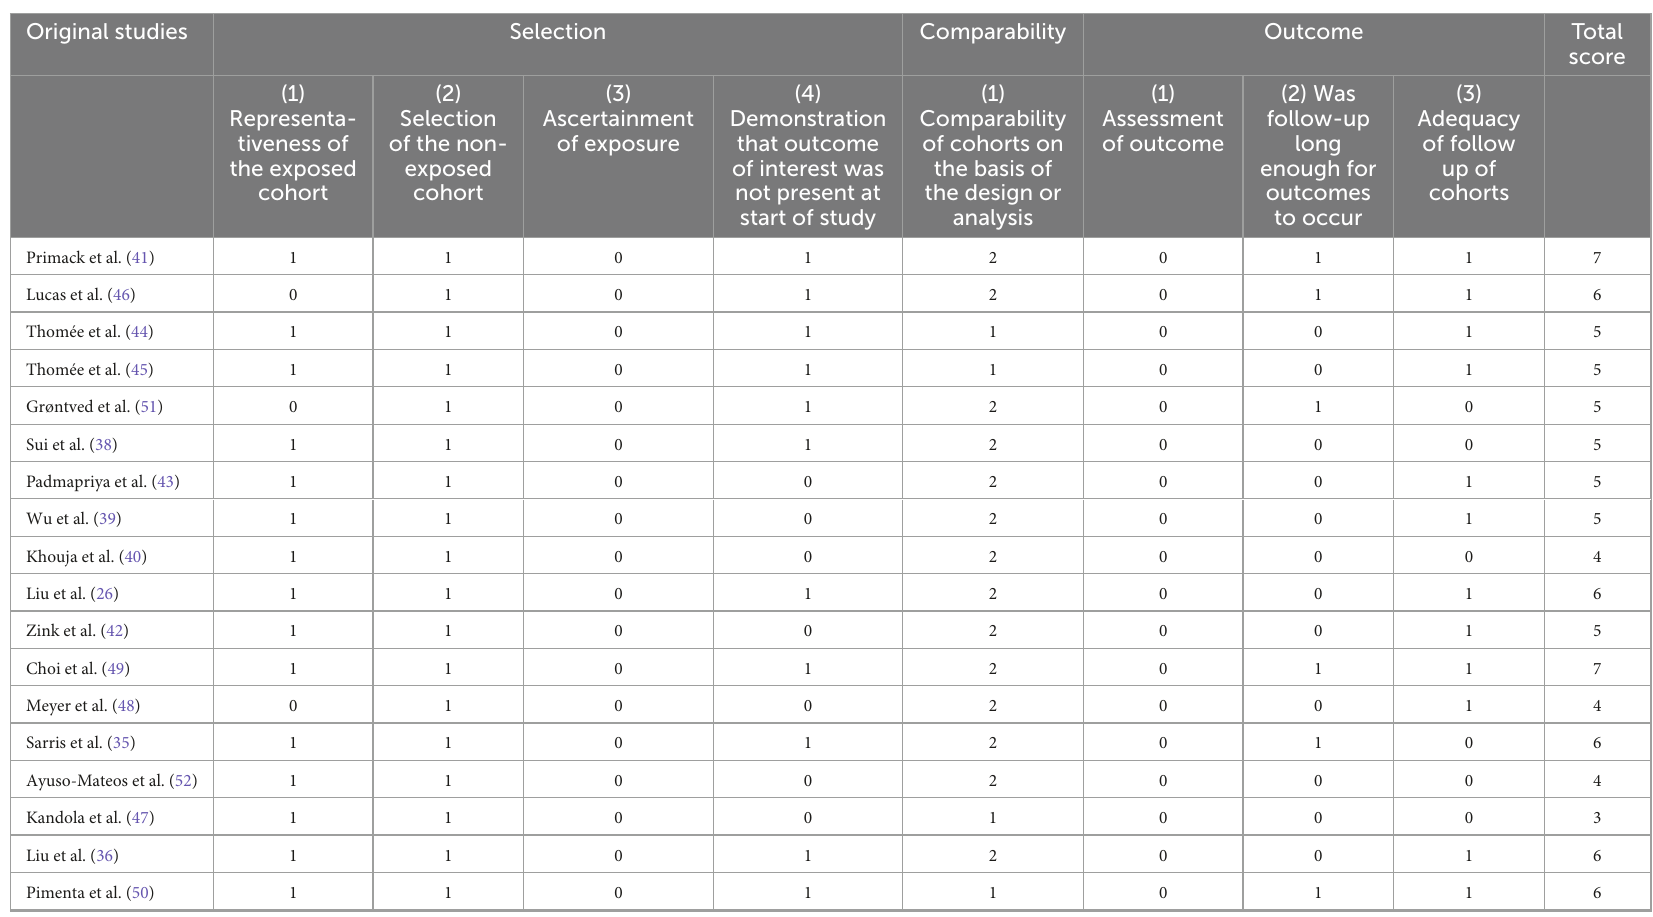
TABLE 2 Quality assessment of included cohort